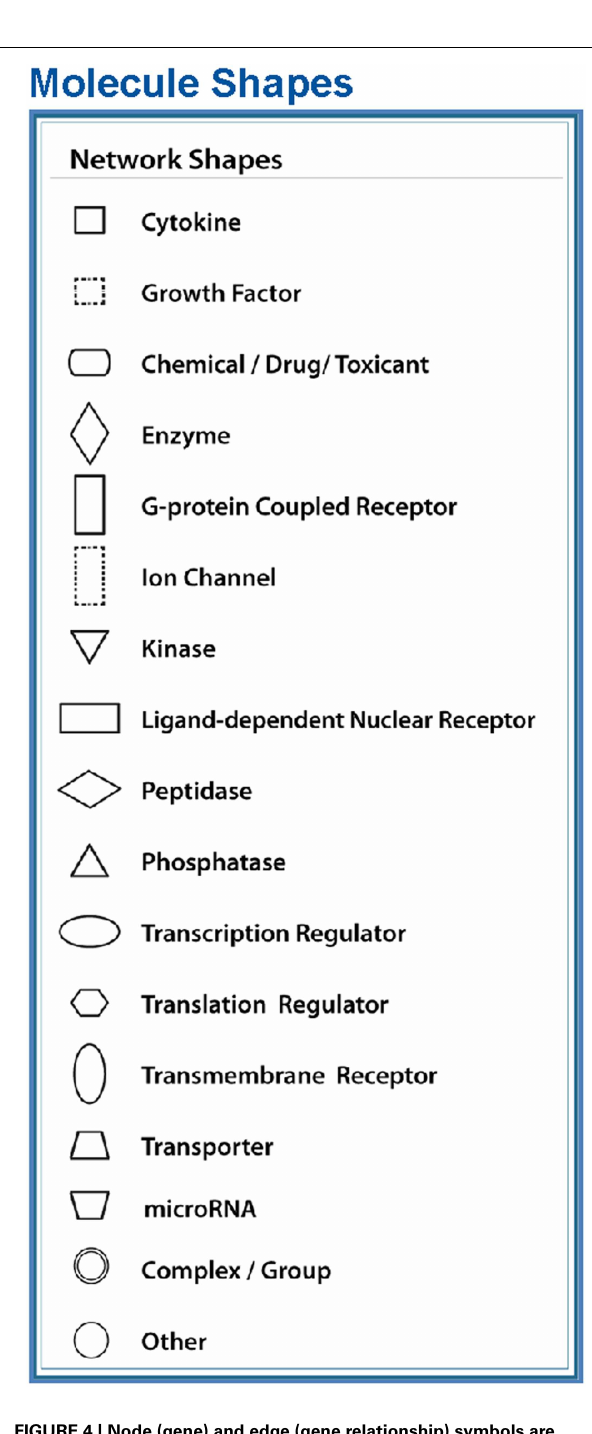
FIGURE 4 | Node (gene) and edge (gene relationship) symbols are described in the figure .The intensity of the node color-( red ) indicates the degree of upregulation. Genes in uncolored nodes are not identified as differentially expressed genes in our experiment and are integrated into the computationally generated networks on the basis of the evidence stored in the IPA knowledge memory indicating a relevance to this network.The node shapes denote enzymes, phosphatases, kinases, peptidases, G-protein-coupled receptors, transmembrane receptors, cytokines, growth factors, ion channels, transporters, translation factors, nuclear receptors, and transcription